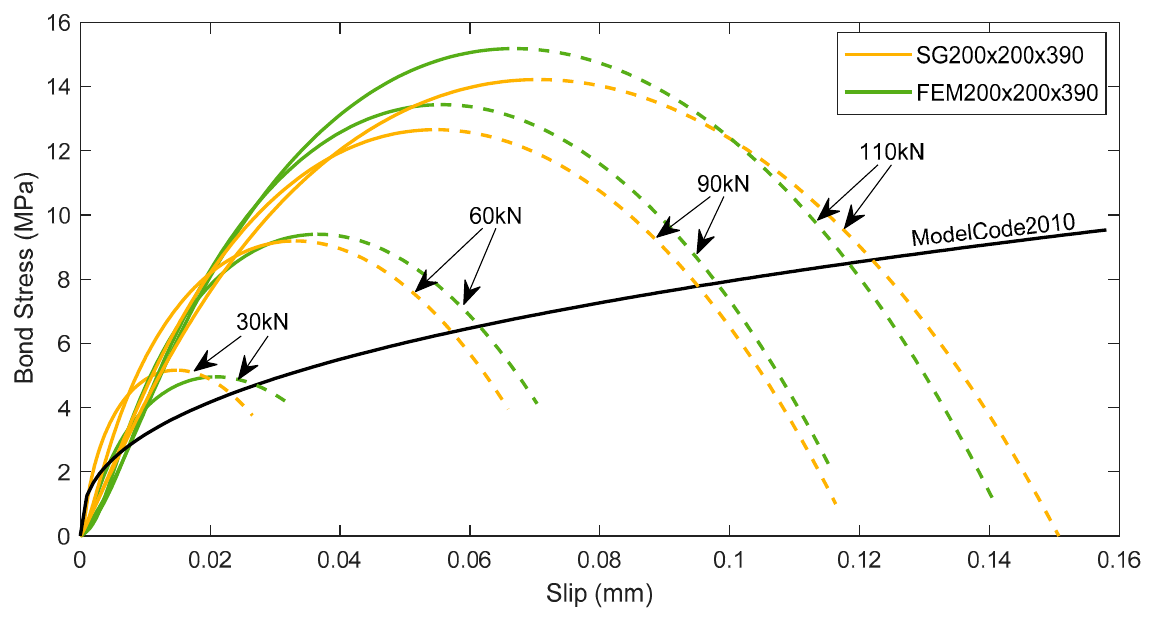
Figure 9. Comparison of bond-slip behavior between SG200×200×390 and FEM200×200×390 at several load levels.